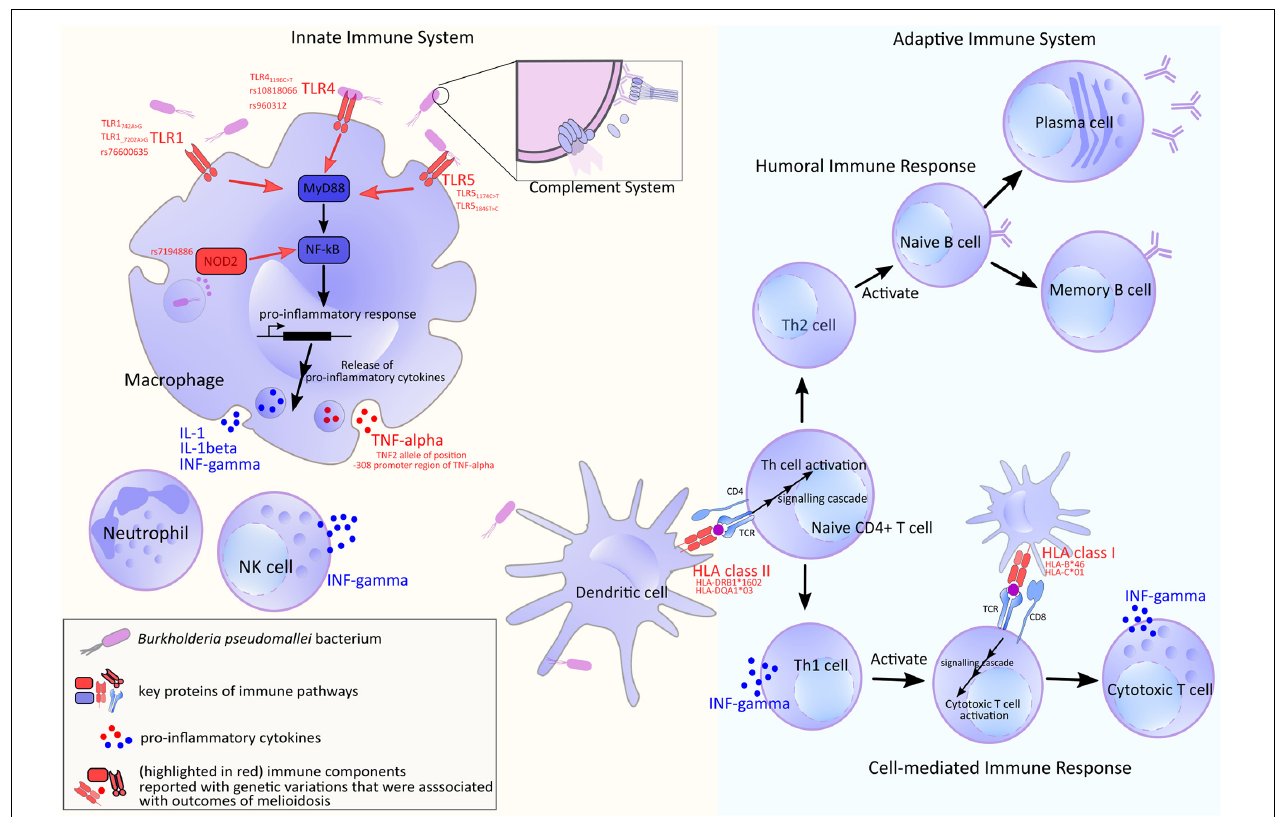
FIGURE 3 | A summary of human host immune components used in defending against B. pseudomallei. Genes or molecules that show genetic variations are marked in red. Upon infection, the bacterial antigens are recognized by host receptors including Toll-like receptor (TLR) and HLA which also display large genetic diversity. The latter is reported to be varied by ethnic groups (de Bakker et al., 2006; Gourraud et al., 2014). Following an entry into host, B. pseudomallei faces the innate axis of the immune system. Macrophages and neutrophils are recruited to the site early upon the infection; these cells are reported to be essential to the early bacterial containment and clearance (Breitbach et al., 2006; Easton et al., 2007), though excessive recruitment of neutrophils may have a negative outcome that allows B. pseudomallei to propagate intracellularly (Ceballos-Olvera et al., 2011). These innate phagocytes possess pattern recognition receptors (PRRs), such as surface receptors TLR2, TLR4, and TLR5, as well as, cytosolic receptors NOD2; these are reported to be vital for the fight against B. pseudomallei (West et al., 2008; Myers et al., 2014; Weehuizen et al., 2015; Birnie et al., 2019). The signals transduced by these receptors result in mobilization of nuclear factor NF- κ B which trigger appropriate immune responses including the synthesis of pro-inflammatory cytokines and initiation of the downstream adaptive immune cascades (Pothlichet and Quintana-Murci, 2013). It is through the antigen-presenting cells and their appropriate antigen-HLA class II complexes that enable the activation of CD4 + T lymphocytes. The naïve CD4 + T cells sit at the central part of the adaptive axis. They can differentiate into Th1 cells which facilitate cell-mediated immune response by CD8 + cytotoxic lymphocytes. A study has shown that strong CD4 + and CD8 + T cell response was elicited during acute melioidosis and the lower